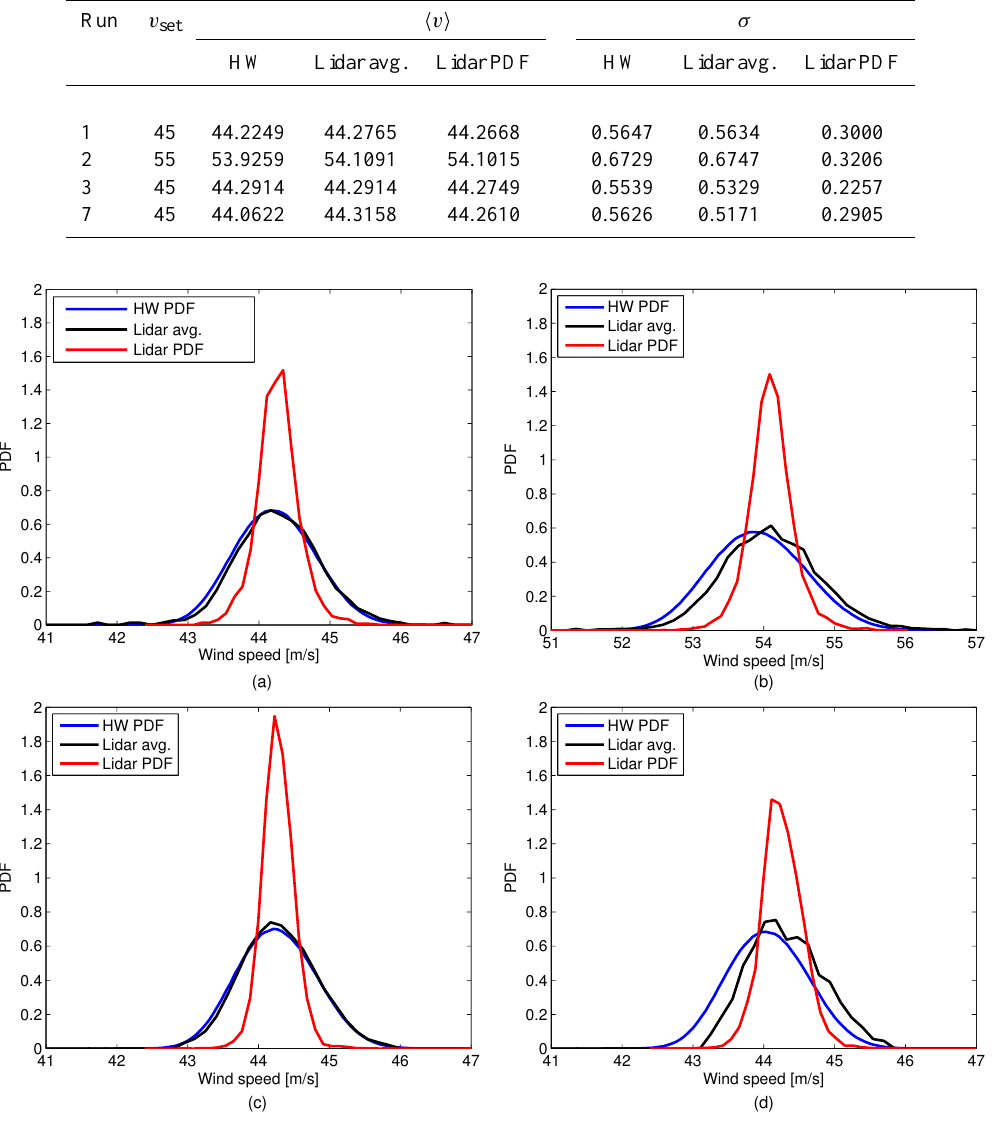
Fig. 7. The pdfs based on the HW and lidar measurements together with the ensemble averaged lidar spectrum and the pdf obtained from the lidar wind speed time series. The four figures (a-d) correspond respectively to run 1, 2, 3 and 7. See Table